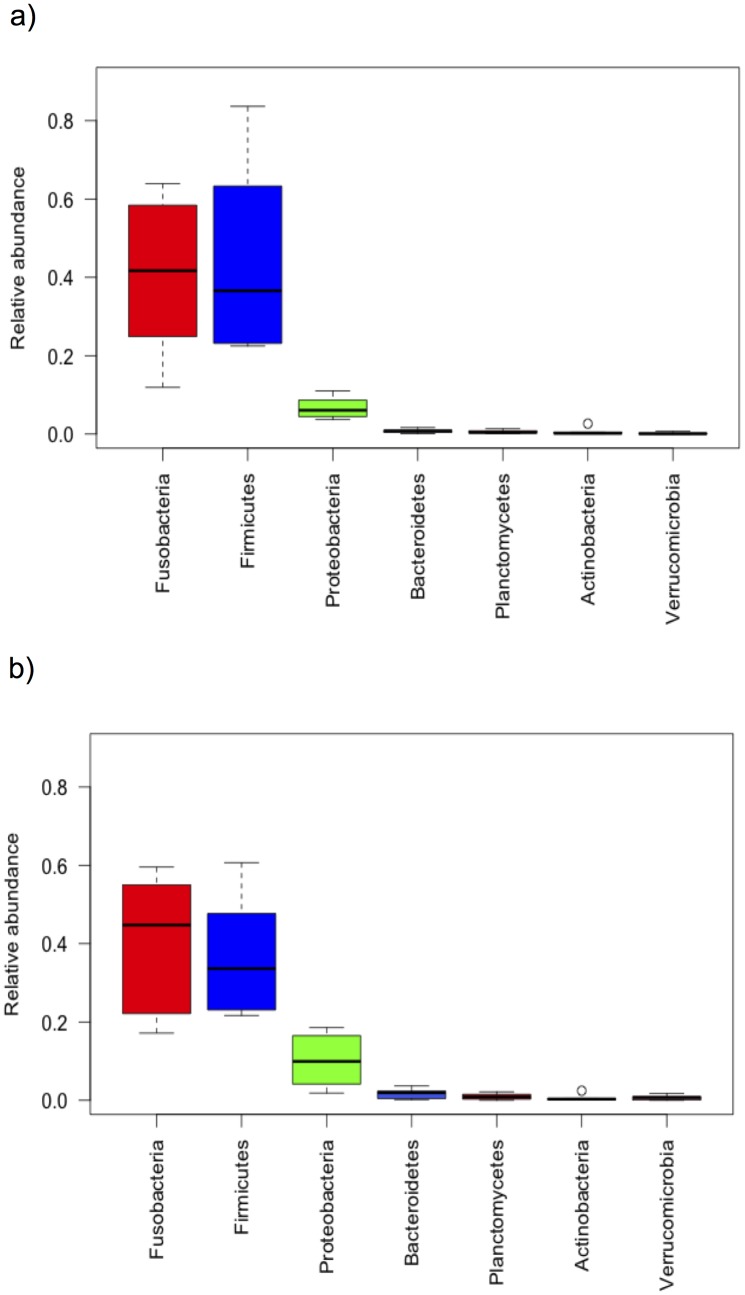
Relative abundance of the seven cichlid core phyla in V12 (a) and V34 (b).Interquartile ranges (25th and 75th percentiles) and whiskers show data dispersion across species averages. Medians are shown as central horizontal lines. The two libraries returned a highly concordant pattern of core phyla abundance: the cichlid gut microbiota is dominated by Fusobacteria, Firmicutes and Proteobacteria, with the first two phyla largely fluctuating in relative abundance across species. Bacteroidetes, Planctomycetes, Actinobacteria and Verrucomicrobia are consistently less represented in all species (overall contributing less than 1% of the total reads).